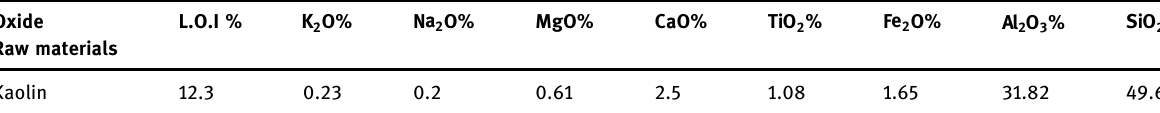
Table 2: Chemical analysis of raw materials